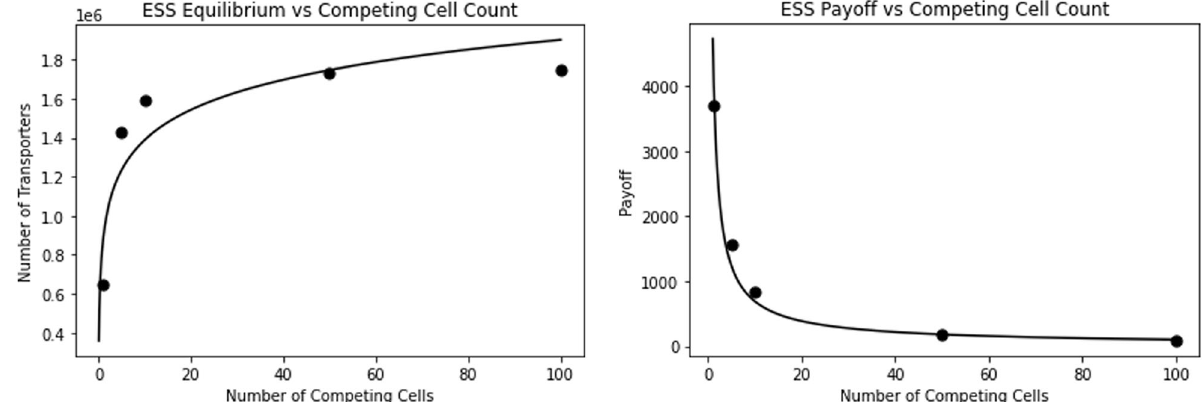
Fig. 3 Nutrient uptake and transporter production as functions of competing cells. ESS transporter equilibrium increases in a logistic manner while the ESS payoff per cell deceases in a power-law manner as a function of N